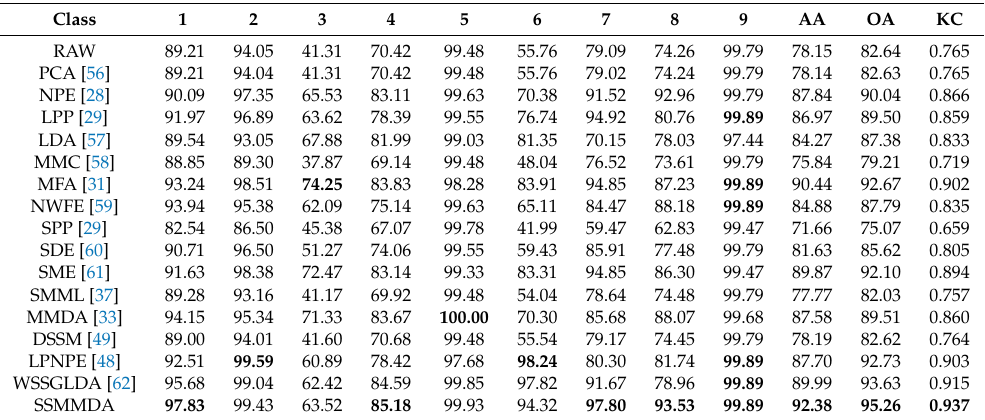
Table 4. Classification results (%) of each class (t = 0.5%) with NN classifier on the PaviaU data set.